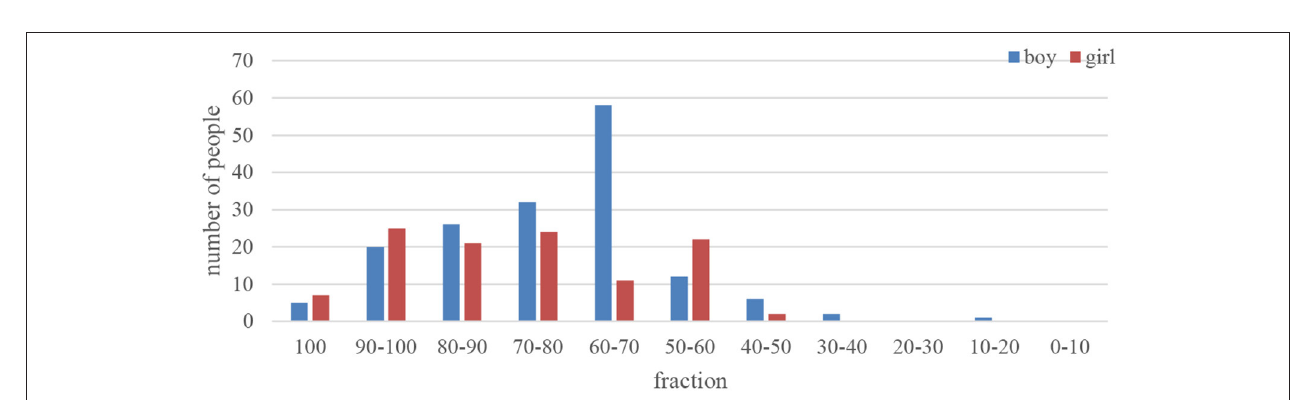
FIGURE 9 | Comparison of teacher–student relationship.